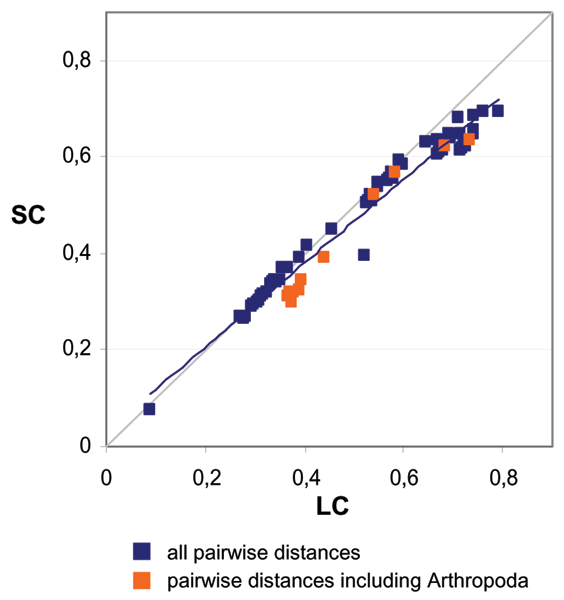
Comparison of evolutionary distances. The datasets are the same as in Figure 5. The phylogenetic inferences were obtained as for Figure 5. Pairwises of patristic distances are plotted in blue (dots including Arthropoda in orange).